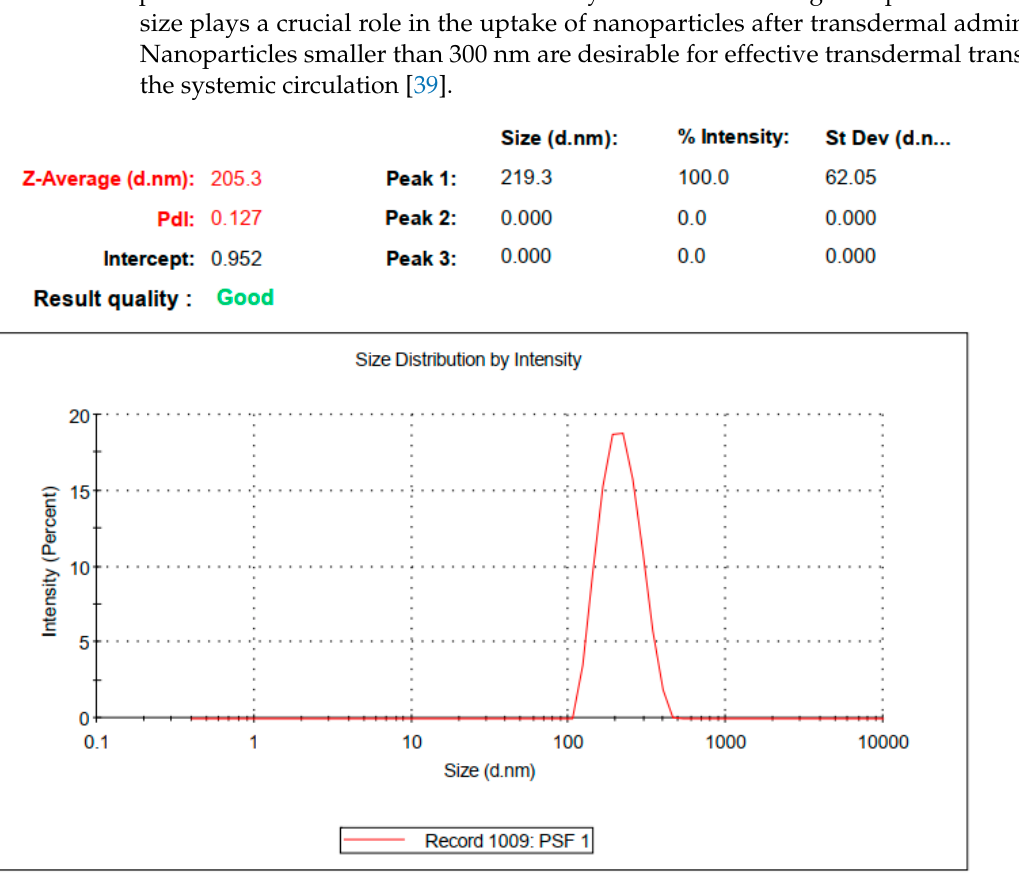
Figure 1. Particle size distribution of optimised drug loaded formulation of SLNs. PDI value below 0.3 indicates homogenous distribution; hence, it is evident that